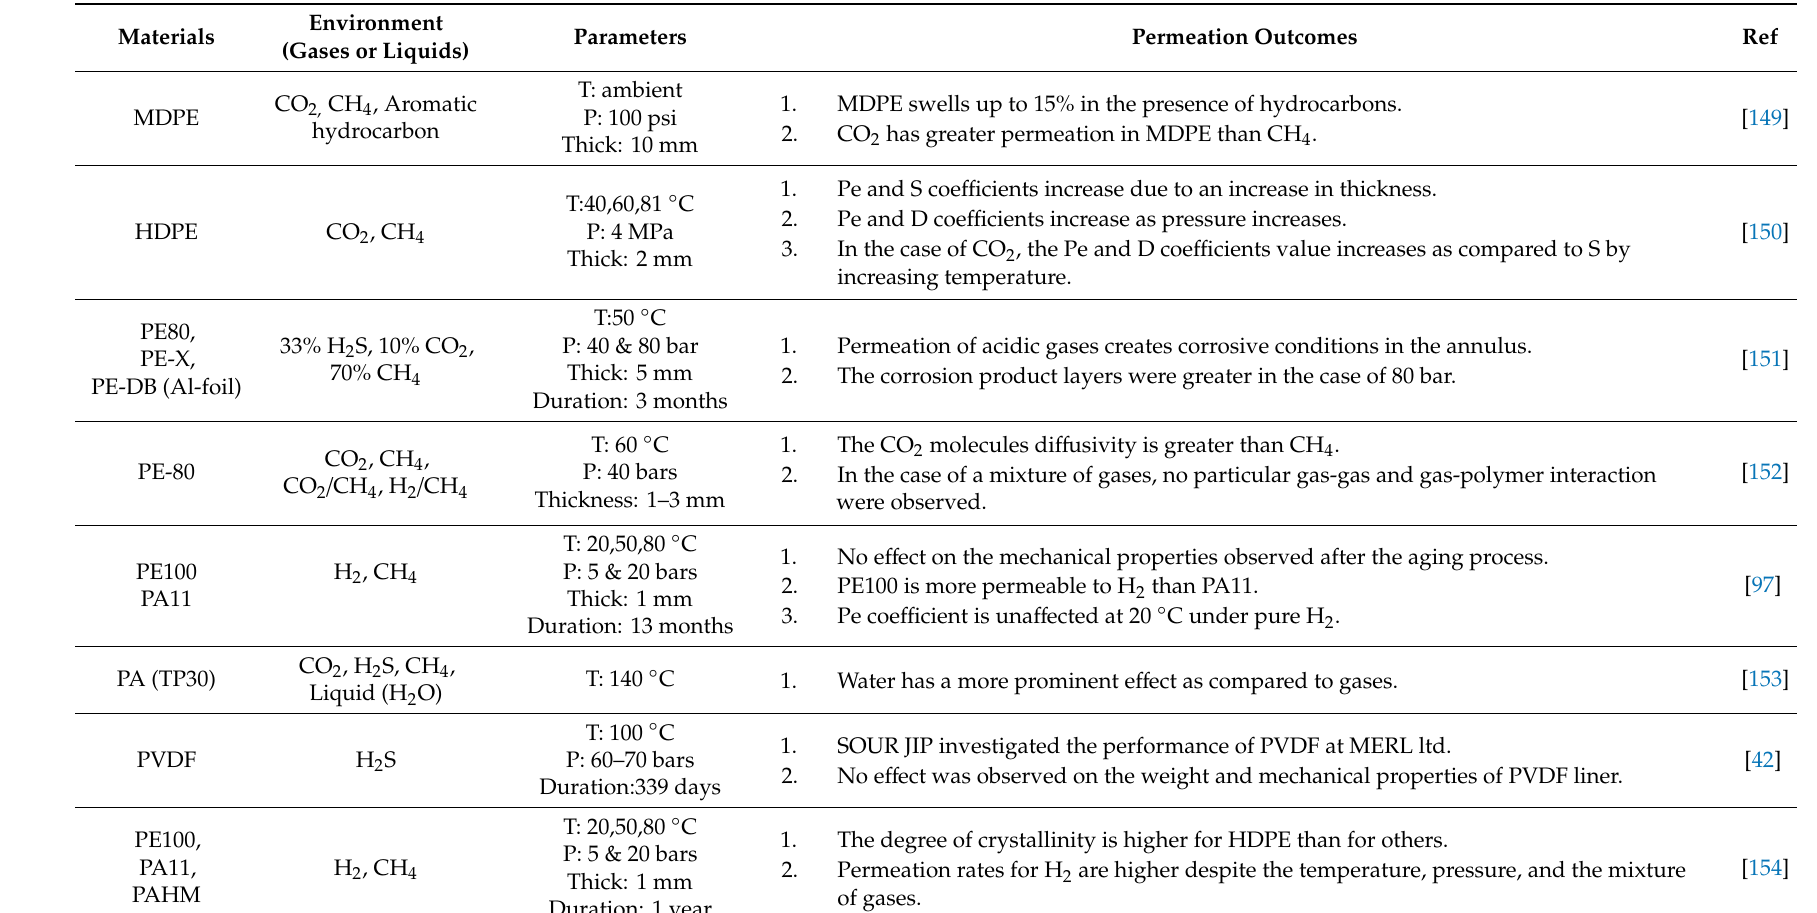
Table A2. Permeation (Exposure and